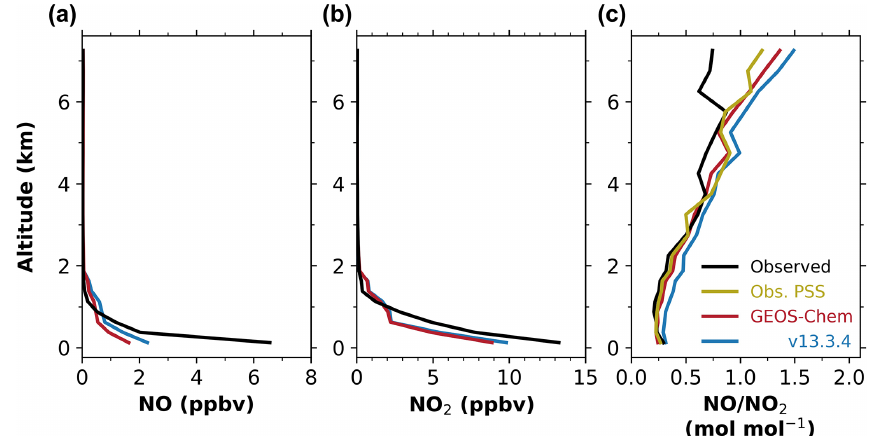
Figure 3. Median vertical profiles of NO and NO 2 concentrations (a, b) and NO / NO 2 concentration ratios (c) in the SMA (37–37.6 ◦ N, 126.6–127.7 ◦ E) during the KORUS-AQ campaign. Observations are compared to our GEOS-Chem simulation and the standard ver- sion 13.3.4 of the model. PSS for the NO / NO 2 ratio denotes a photochemical steady state as given by Eq. (4) and is computed mainly from observed quantities. Observed NO / NO 2 ratios and PSS are computed only if both species are more than 2 times above the limit of